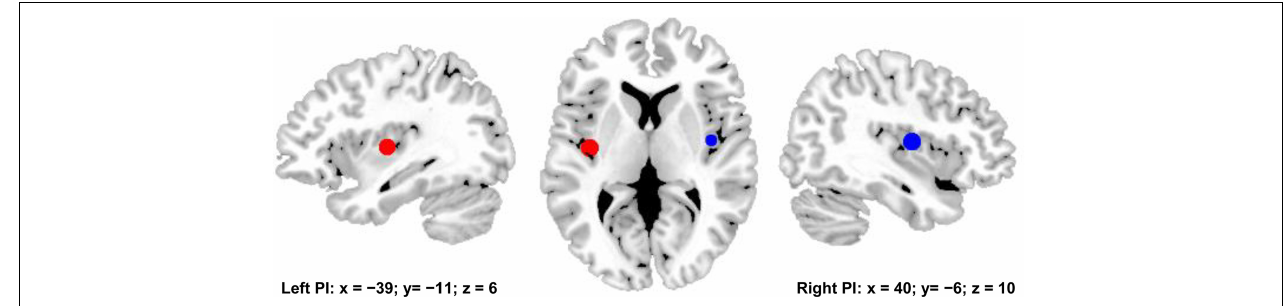
FIGURE 1 | Bilateral posterior insula (PI) were used to define pain matrix. The center MNI coordinates were used to draw spheres with 6 mm radius for functional connectivity analyses. The center MNI coordinate for left PI is [–39, –11, 6], and the center MNI coordinates for right PI is [40, –6,